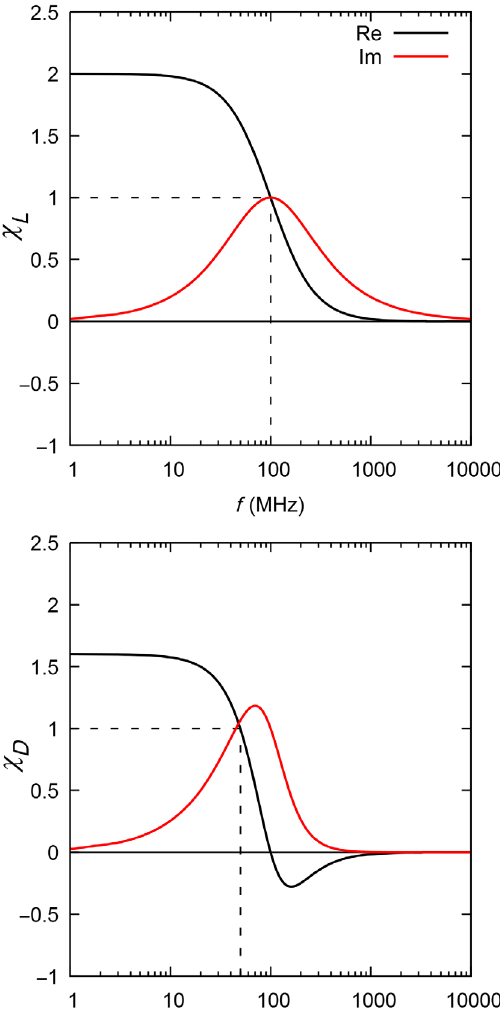
FIG. 6. Response function examples. Top: Debye relaxa- tion τ ¼ 1 . 6 ns, Bottom: Lorentzian f o ¼ 50 MHz and δ ¼ 250